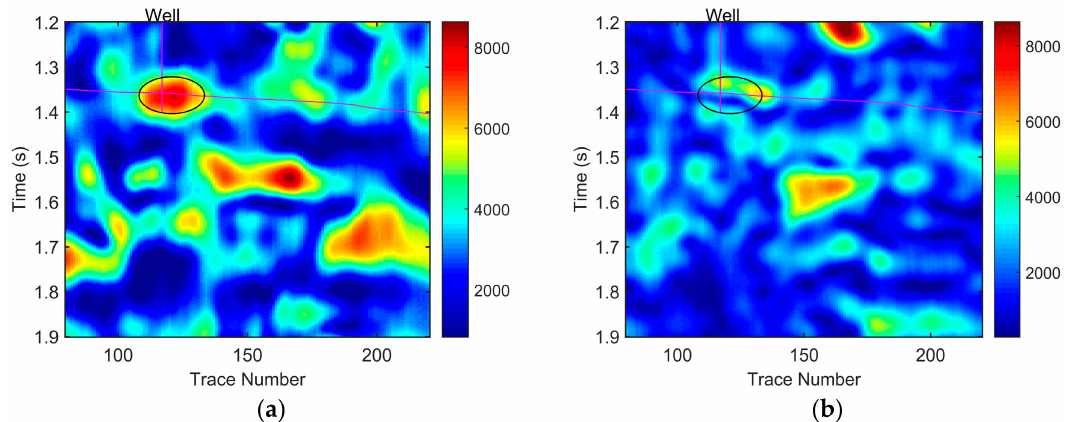
Figure 10. Constant frequency sections based on GST ( a ) at 40 Hz and ( b ) at 50 Hz.